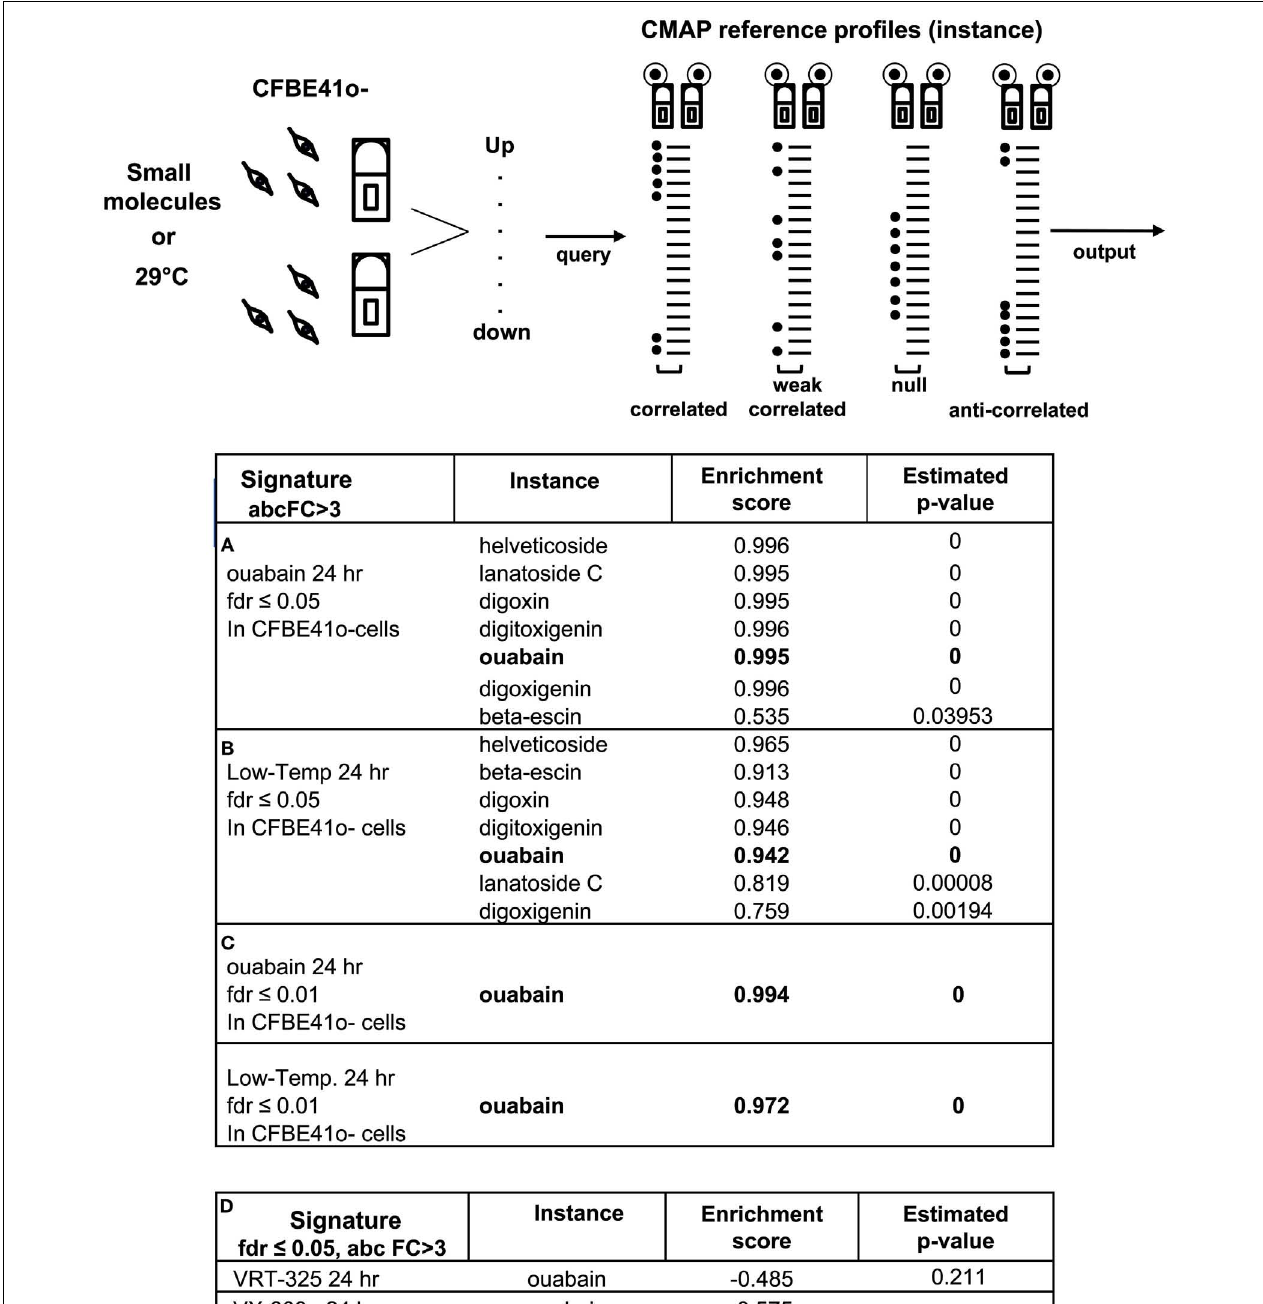
(anti-correlated). (A) The genomic changes induced in polarized parental CFBE41o-cells by ouabain 24h query signature is correlated with ouabain and six cardiac glycosides previously established profiles in CMAP (instances). (B) The genomic changes induced in polarized parental CFBE41o-cells by low temperature 24h specific-signature is highly ranked with ouabain and six cardiac glycoside instances. (C) More stringent query signature (FDR ≤ 0.01) increases the ability of low temperature to recover ouabain instance in the CMAP. (D) The genomic changes induced in polarized parental CFBE41o-cells by 10 µ MVRT-325 and by 1 µ MVX-809 query signatures are respectively weakly anti-correlated and null-correlated with the previously established ouabain profile in